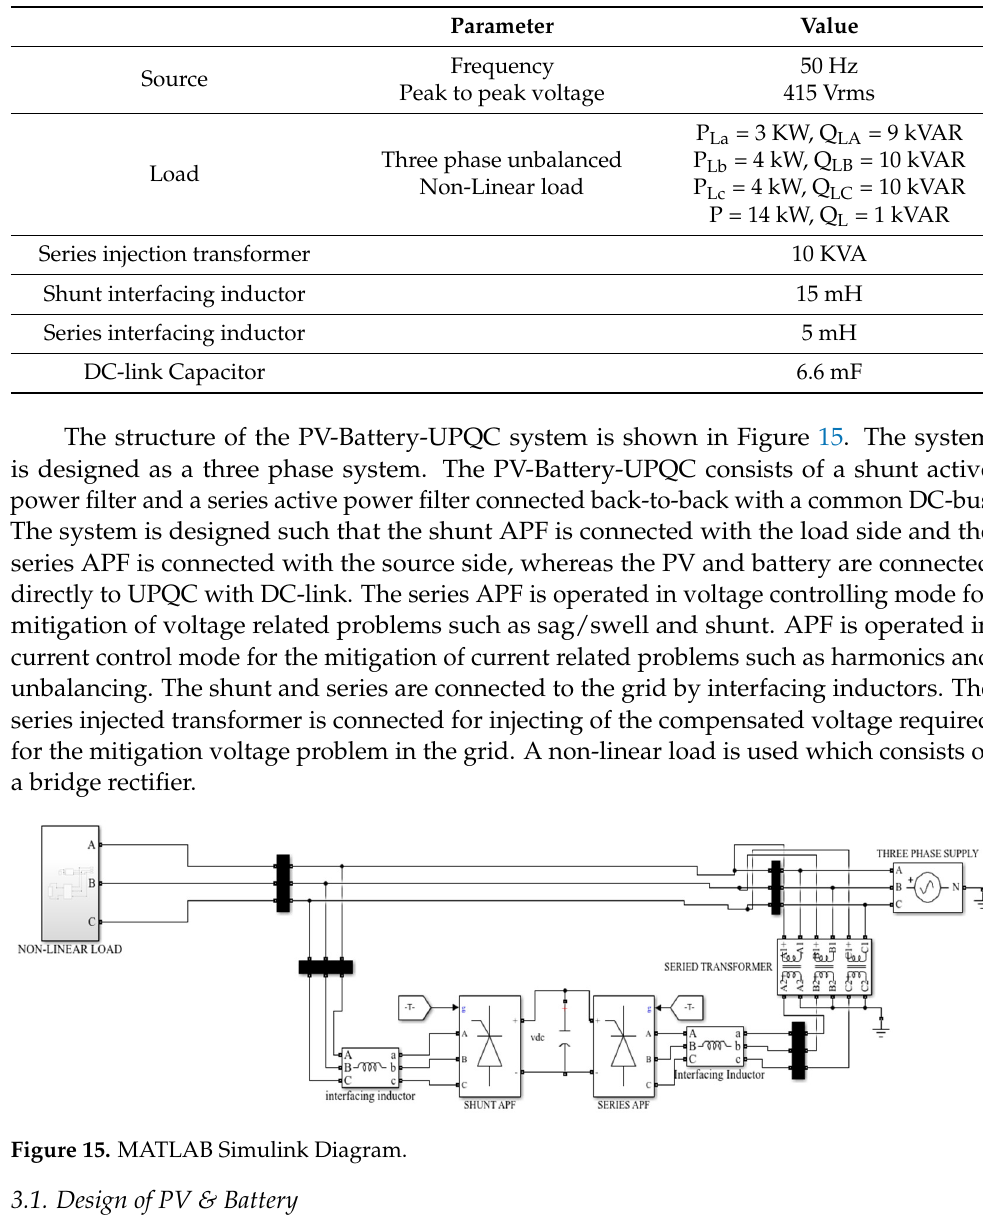
Table 1. Designing parameters of PV-Battery-UPQC-system.